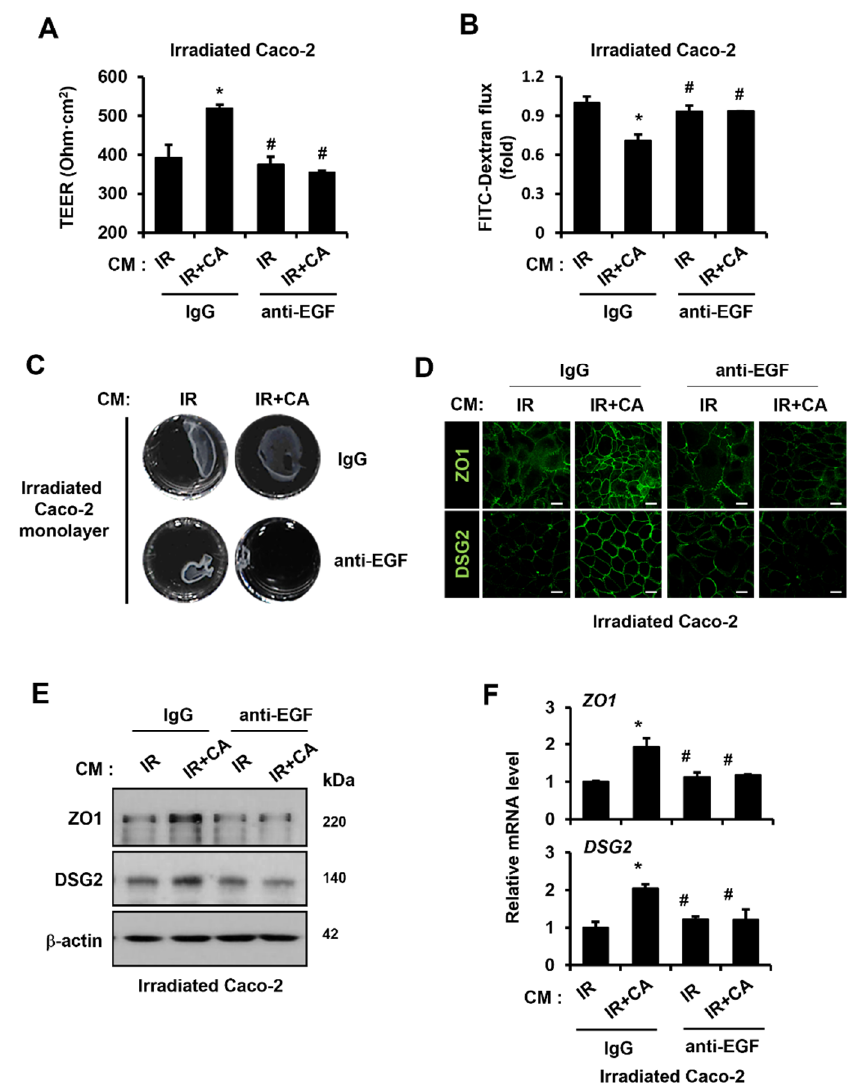
Figure 6. Centella asiatica -derived endothelial epidermal growth factor rescues radiation-induced barrier impairment with upregulation of zonula occludens 1 and desmoglein 2. ( A ) Transepithelial electrical resistance (TEER) value of irradiated Caco-2 monolayers on transwells was determined after treatment with CM of irradiated (IR) HUVECs or CA-treated IR (IR + CA) in presence of neutralizing antibody to EGF (anti-EGF, 100 ng/mL). The bar graph is shown as TEER value of each group. ( B ) The flux of FITC-dextran (4 kDa) in lower chambers was measured using a microplate fluorescence reader (excitation at 450 nm and emission at 520 nm). The bar graph is shown as a fold of flux of fluorescence normalized to irradiated Caco-2 monolayers treated with CM of IR. ( C ) Dispase-based dissociation activity of each irradiated Caco-2 monolayer was determined. Prepared irradiated Caco-2 monolayers were incubated in dispase II (2.4 U/mL) and collagenase type I for 30 min. After applying mechanical stress, the fragmentation of Caco-2 monolayers was observed using a digital camera. ( D ) The intensity of zonula occludens 1 (ZO1) and desmoglein 2 (DSG2) on the intercellular junction of irradiated Caco-2 monolayers was assessed by confocal staining. ( E ) Protein levels of ZO1 and DSG2 were assessed by western blot analysis. ( F ) mRNA levels of ZO1 and DSG2 were assessed by qRT-PCR. Data are presented as the mean ± standard deviation of the mean; n = 3 per group. * p < 0.05 compared to the CM of IR-treated irradiated Caco-2 monolayers; # p < 0.05 compared to the CM of IR + CA treated irradiated Caco-2 monolayers. Scale bars represent 10 µm. All data represent at least two independent experiments.